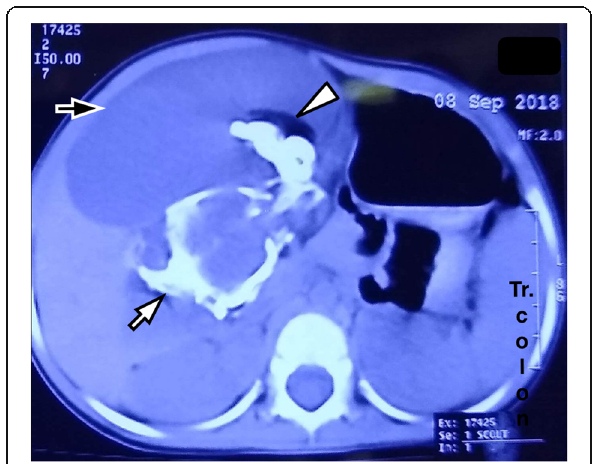
Fig. 1 Axial CECT scan section at the level of the hepatoduodenal ligament, showing the mass with cystic areas (arrow with white outline), calcification (arrow with black outline) and fatty areas (arrowhead)